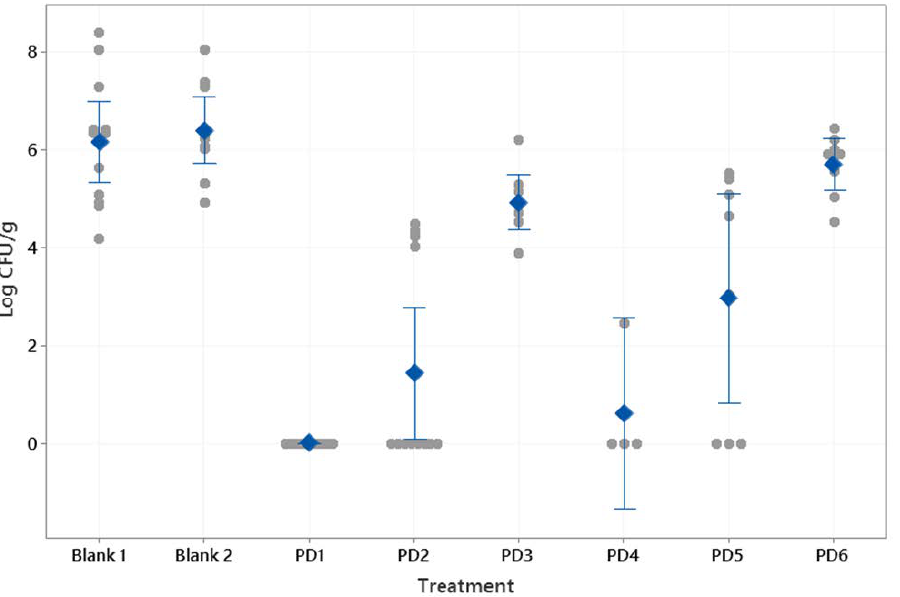
Figure 6. Bacterial count (CFU/g) found in mice stomachs after antibiotic treatments at different doses and controls (PBS and Mucolast ® ). Circles: individual CFU/g values. Diamonds: mean value. Inter- val bars: 95% confidence interval. Blank 1: Mucolast ® . Blank 2: PBS. PD1: 89.4 mg/kg/day Amox and 44.7 mg/kg/day Clar in Mucolast ® . PD2: Amox 44.7 mg/kg/day and Clar 22.35 mg/kg/day in Mucolast ® . PD3: Amox 8.94 mg/kg/day and Clar 4.47 mg/kg/day in Mucolast ® . PD4: Amox 357.5 mg/kg/day and Clar 178.8 mg/kg/day in PBS. PD5: Amox 89.4 mg/kg/day and Clar 44.7 mg/kg/day in PBS. PD6: Amox 44.7 mg/kg/day and Clar 22.35 mg/kg/day in